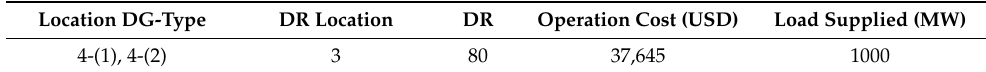
Table 12. Sizing of distributed energy resources.